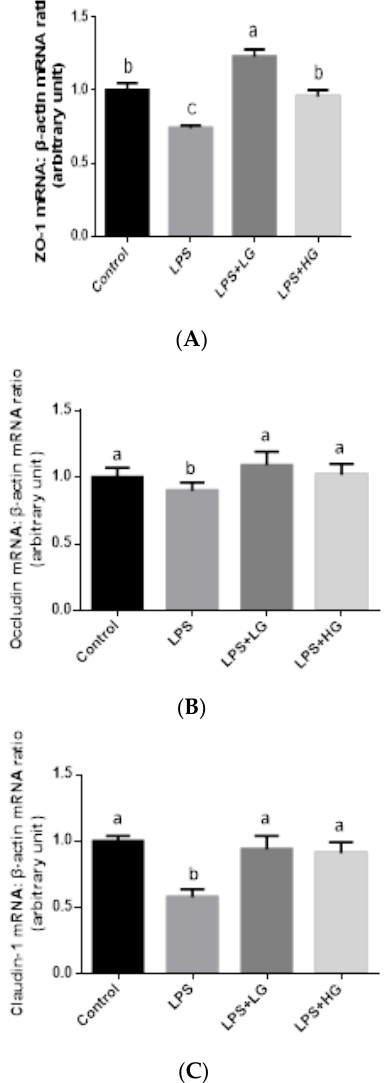
Figure 1. mRNA expression level of tight junction proteins in the jejunal mucosa of piglets fed di ff erent molecular weight β -glucan. Data are shown as means ± SE. ( A ) ZO-1 mRNA expression level. ( B ) Occludin mRNA expression level. ( C ) Claudin-1 mRNA expression level. Di ff erent letters indicate statistically significant di ff erences between groups ( P < 0.05). Control: Sterile saline solution treatment group fed basal diet; LPS + LG LPS treatment group fed basal diet; LPS + LG:LPS treatment group fed low molecular weight β -glucan; LPS + HG:LPS treatment group fed high molecular weight β -glucan. n = 8 replicates per group.